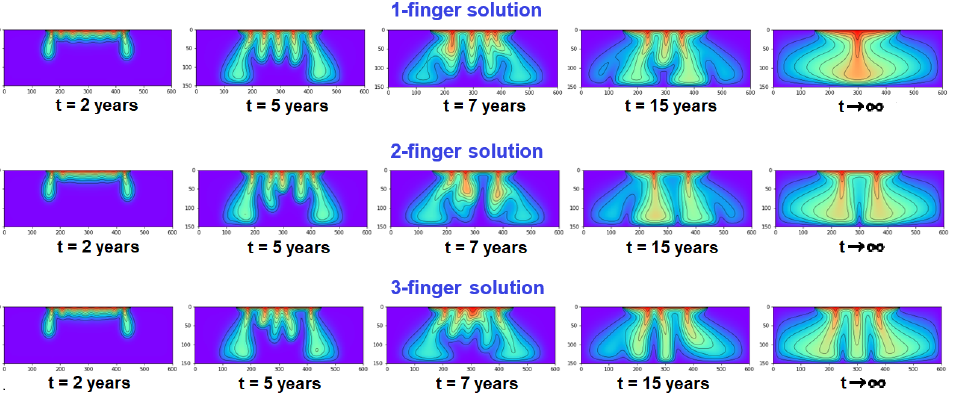
Figure 2. Development in time of the Elder problem for 1-, 2-, and 3-finger